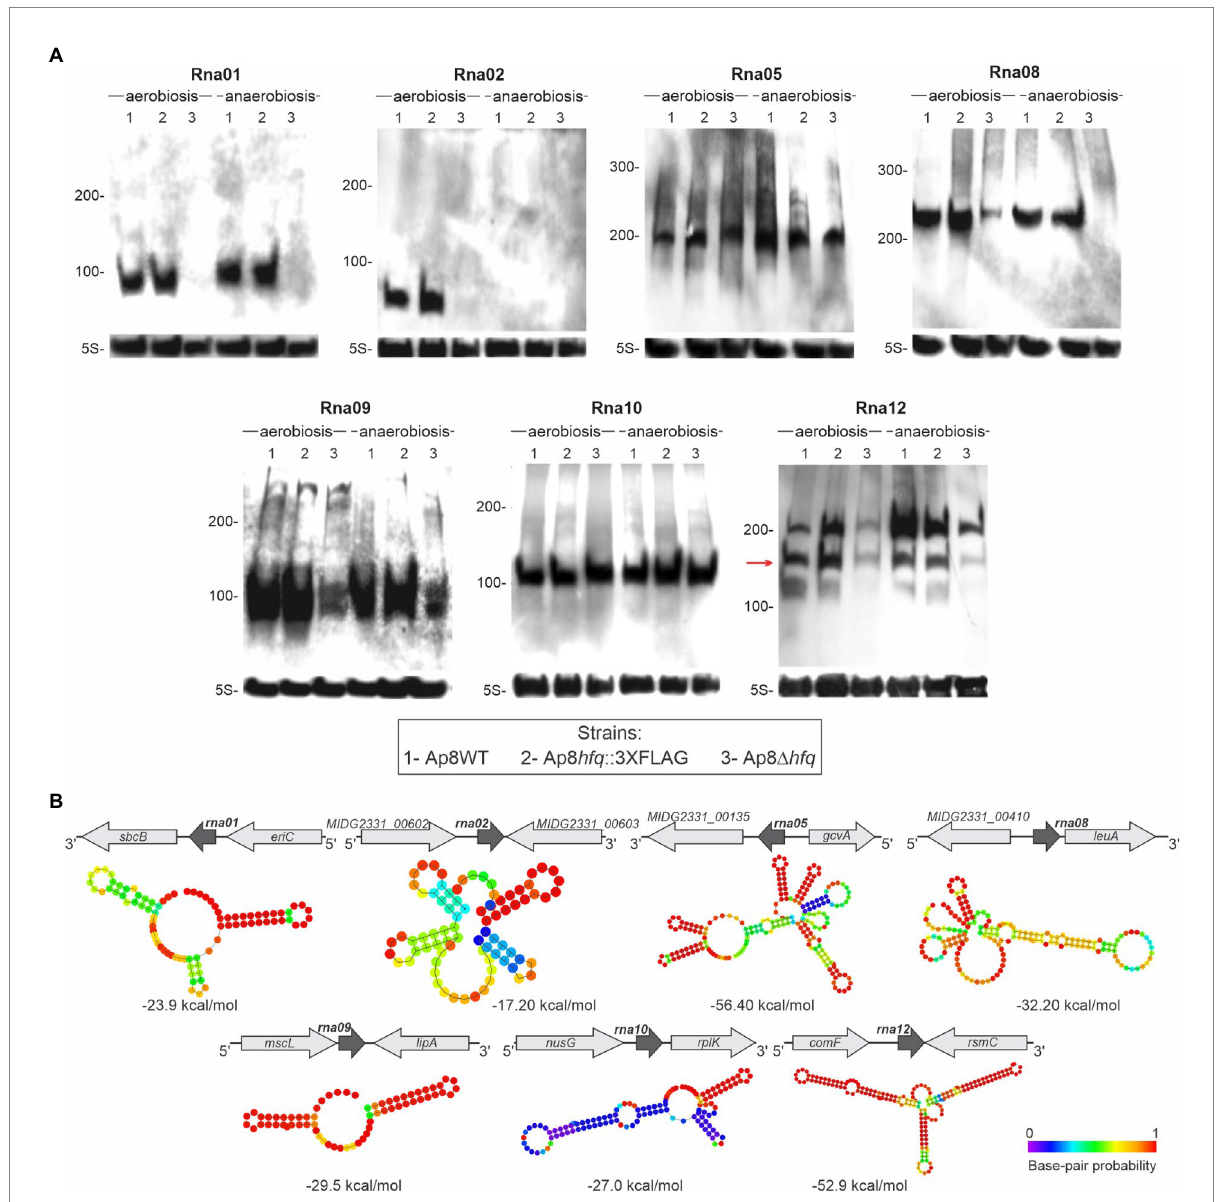
FIGURE 2 Validation of the expression of Hfq-associated sRNAs identified in this work. (A) Expression of sRNAs identified by co-IP using Hfq. Expression was assessed in Actinobacillus pleuropneumoniae Ap8WT (1), Ap8 hfq ::3XFLAG (2), and Ap8 ∆ hfq (3) strains growing under aerobic and anaerobic conditions until late exponential phase. All membranes were reprobed using the rRNA 5S, expressed constitutively. The red arrow represents the band that corresponds to the predicted size for the respective sRNA. The experiment was performed in triplicate. (B) Genic organization and secondary structure of confirmed sRNA candidates, predicted by RNAfold (Lorenz et al., 2011). Free energy ( Δ G) of sRNA structures is showed next to each